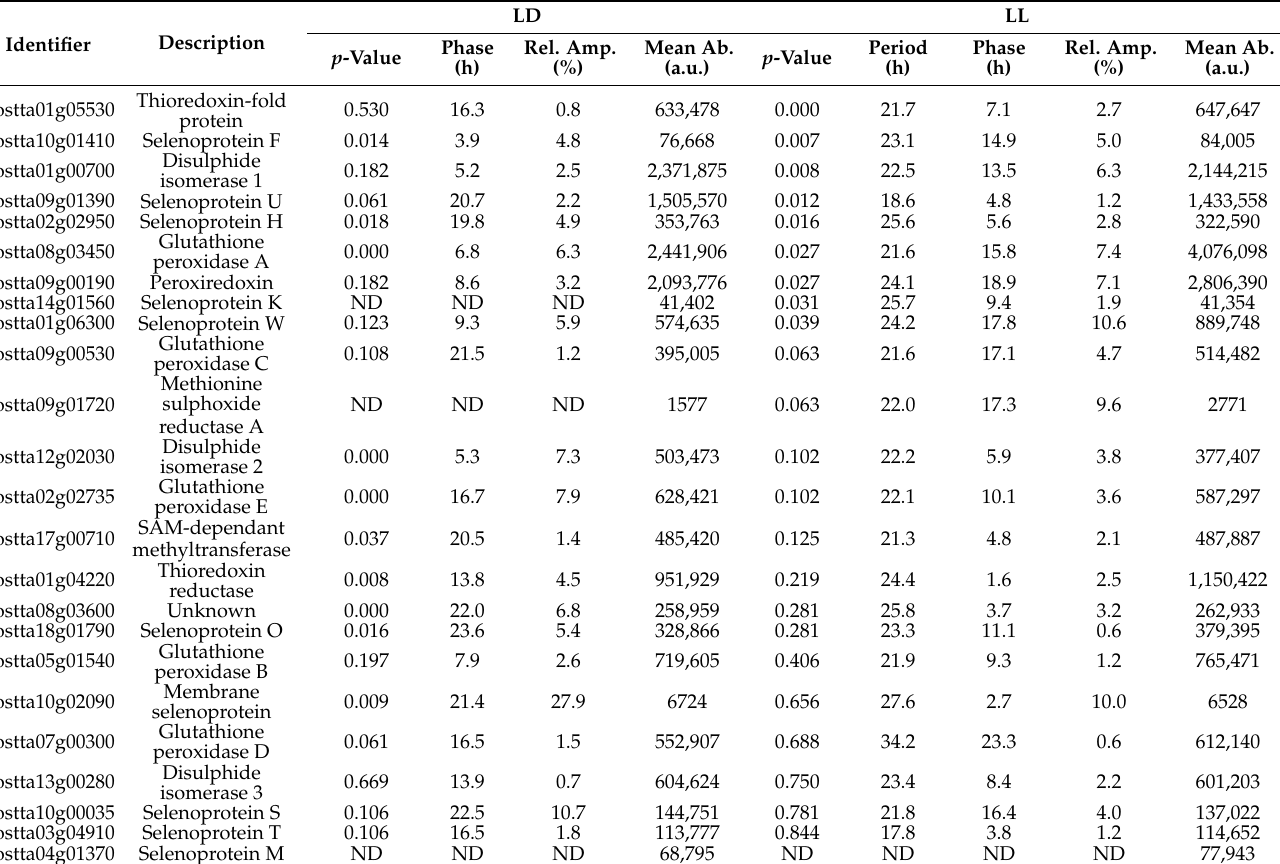
Table 1. The Ostreococcus selenoproteins and rhythmicity parameters under light/dark cycles (LD) or constant light (LL): Provided are the p -value for rhythmicity, phase (in hours; h), relative amplitude (Rel. Amp., in percentage), and mean abundance (Mean Ab., in arbitrary units; a.u.) of the selenoproteins, as detected in our previous proteomics study [23]. ND = not done, meaning the analysis was not possible due to too many missing values in the dataset.